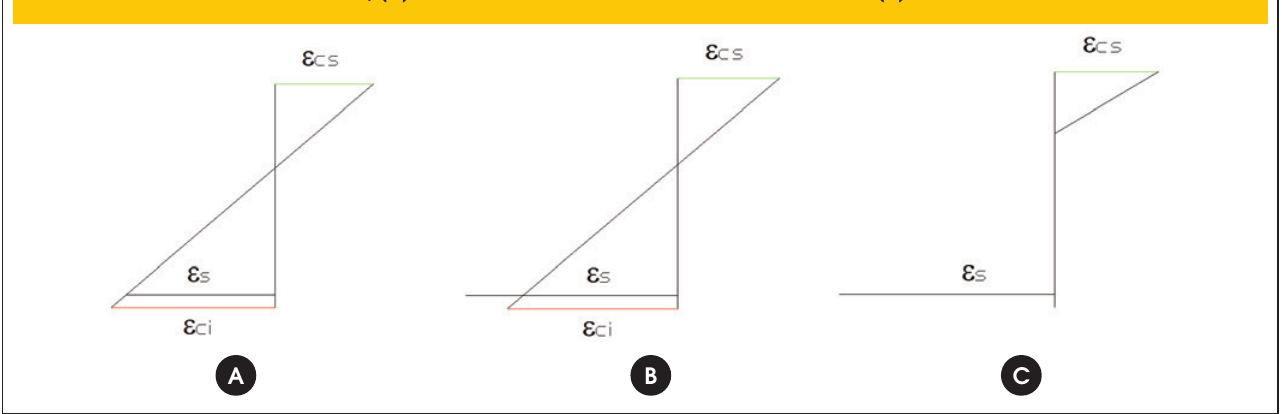
Figure 14 – Strains used to determine experimental bending moments for (a) Uncracked section with ε s deduced, (b) Uncracked section with ε s measured and (c) Cracked